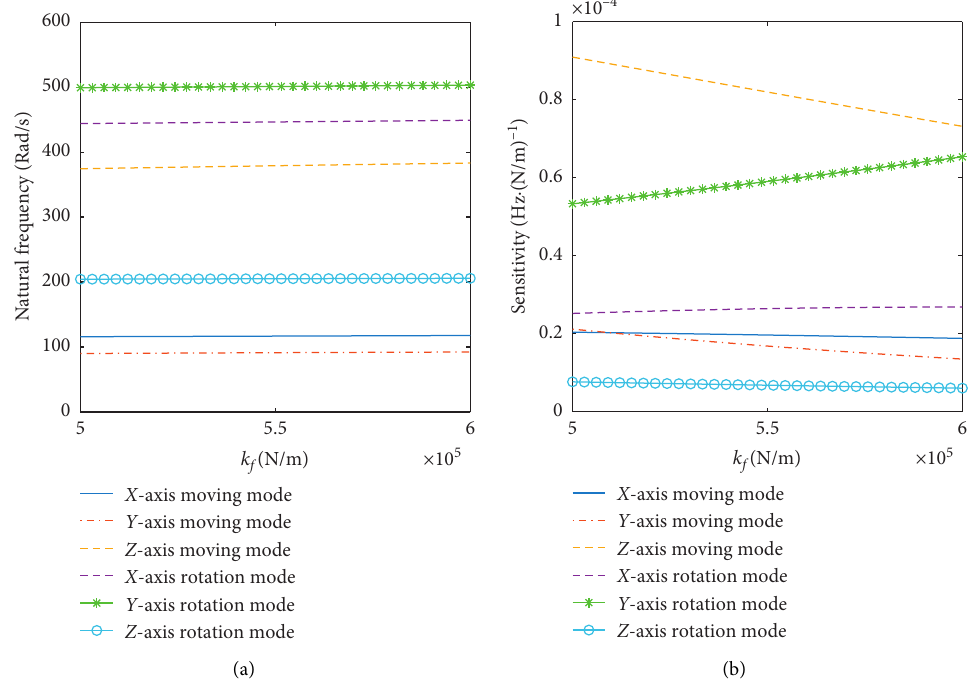
Figure 14: Curve of variation of natural frequency and its sensitivity with stiffness of outer leg 6. (a) Natural frequency. (b) Sensitivity of natural frequency to the stiffness of outer leg 6.